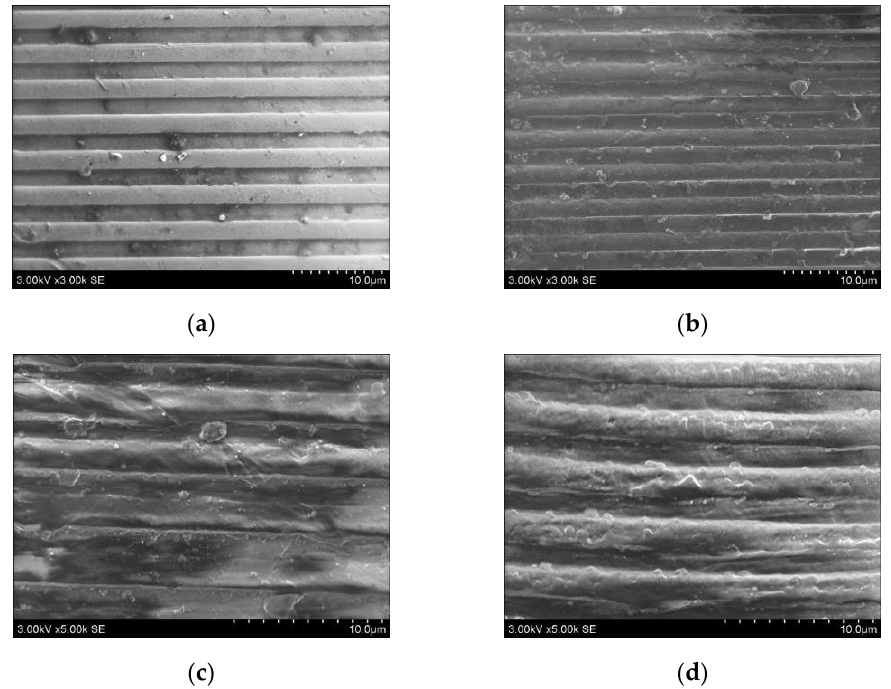
Figure 8. Formation of microstructures: ( a ) microstructure formed in PETG; ( b ) microstructure formed in PP; ( c ) microstructure formed in PVC; ( d ) microstructure formed in SAN.